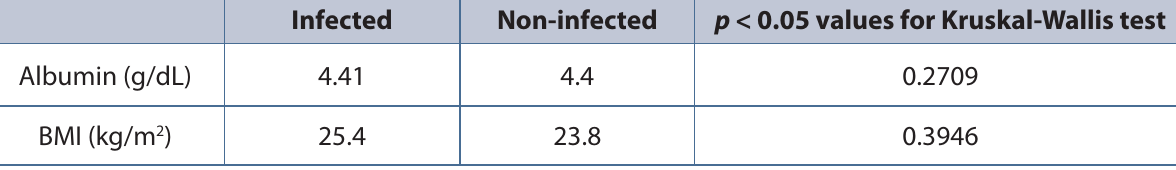
Table 1. Median albumin and BMI values in the 105 HIV/AIDS individuals treated at the Specialized Outpatient Service and Day Hospital Professor Emeritus Domingos Alves Meira, UNESP, 2007-2008. The p values obtained through the Kruskal-Wallis test to compare positive with negative individuals were 0.2709 and 0.3946 for albumin and BMI, respectively